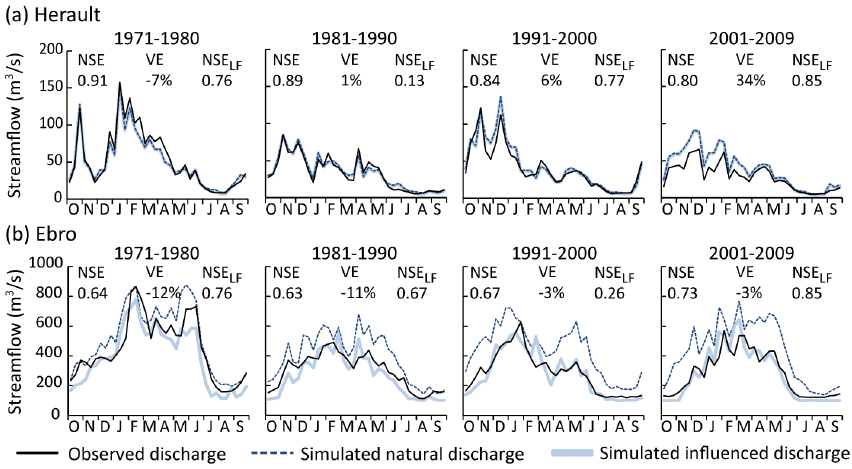
Figure 2. Average observed and simulated discharge per decade and values of Nash (NSE), Volume error (VE) and low flow Nash (NSE LF ) criteria at the outlet of (a) the Herault and (b) the Ebro basins between 1971 and